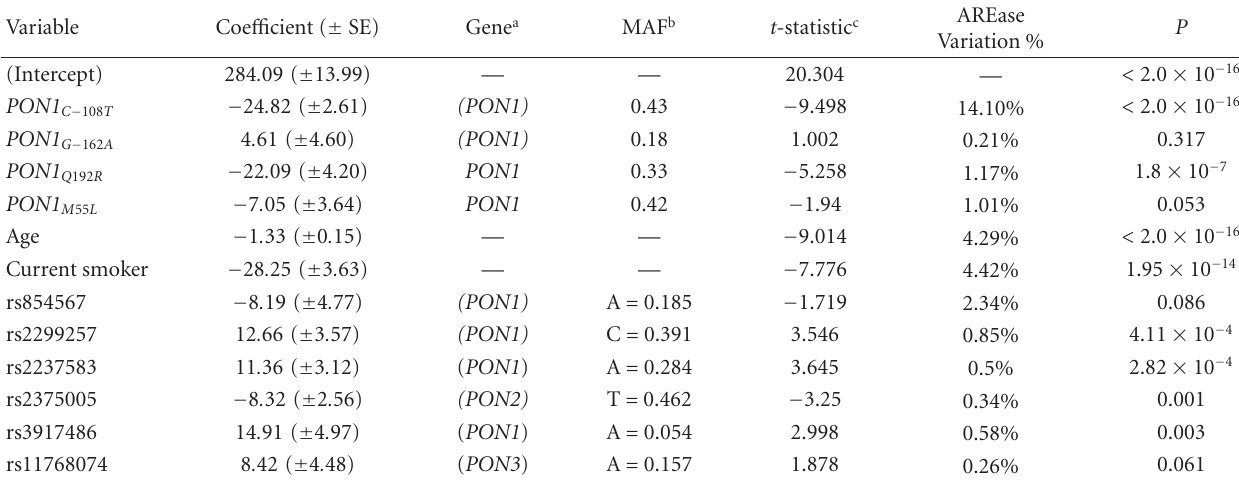
Table 2: Best-fit model from stepwise linear regression predicting PON1 AREase activity.